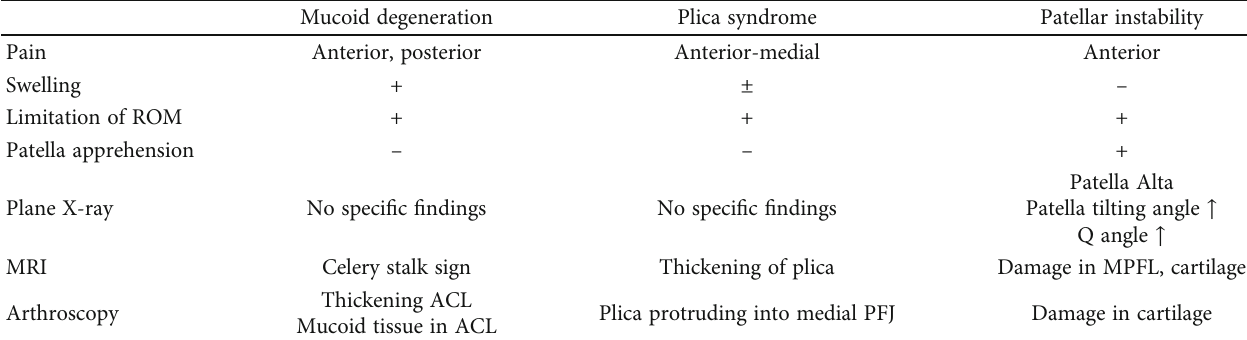
Table 1: Di ff erences among similar